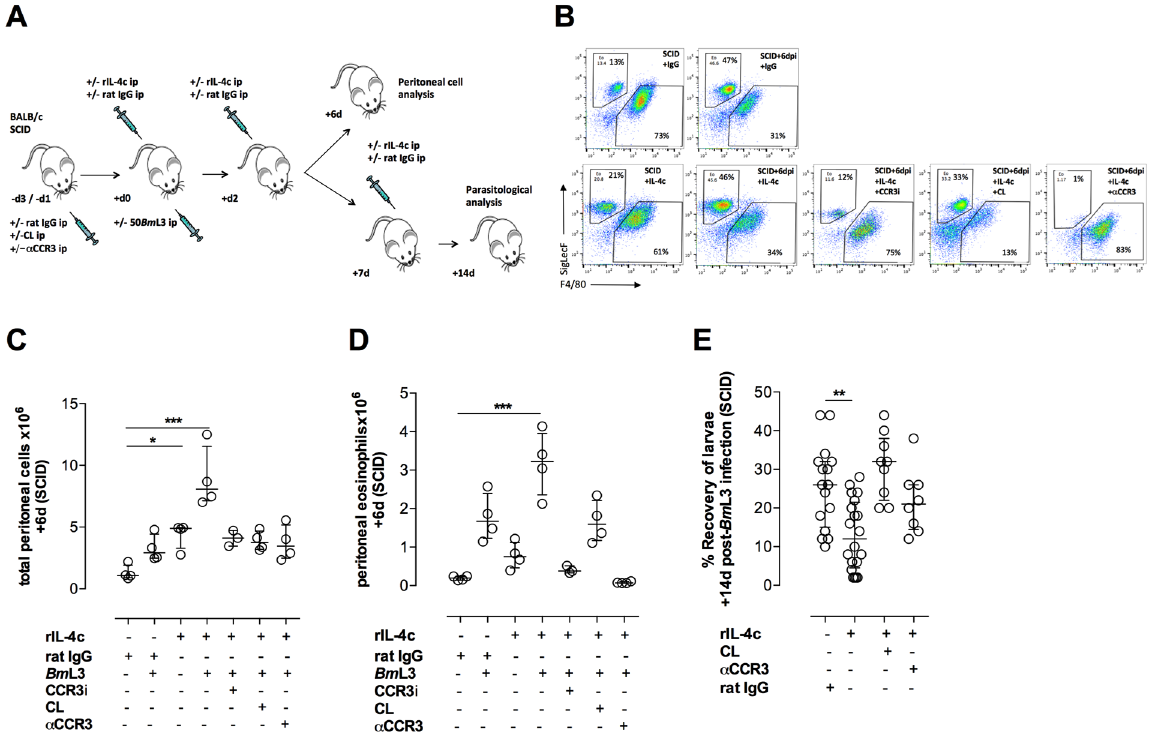
Fig 7. Exogenous IL-4 bolsters CCR3-dependent eosinophilia and the eosinophilic larvicidal response in SCID mice via Bm L3AAM ϕ development. Schematic of experimental approach (A). Flow cytometric assessments of F4/80 M ϕ or SigLecF eosinophil proportions (B), total peritoneal cell number (C), eosinophil number (D) at +6dpi or larval parasite recoveries (E) at +14dpi in BALB/c SCID mice pre-treated ip with either rat IgG, clodronate liposomes (CL) or rat α CCR3 ip, prior to infection with 50 Bm L3 and/or up to three doses of rat IgG (25 μ g), IL-4c (1 μ g rIL-4 complexed to 5 μ g rat anti-IL-4) delivered 0d, +2d, +/- +7d with or without daily oral dosing with CCR3 inhibitor. Data from individual mice with median and interquartile range are plotted. Significant differences between test groups and appropriate rat IgG treated controls assessed by Kruskal-Wallis + Dunn’s tests. Data is representative of two individual experiments (B,C) or pooled from 2–3 individual experiments using groups of 3–6 mice per group / time-point.